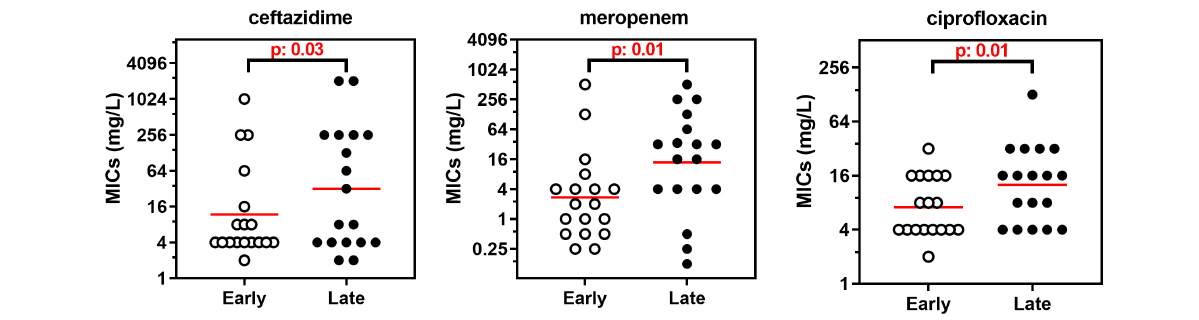
FIGURE 1 | MICs of 3 antibiotics in the 18 pairs of isolates collected successively in the same patients with an interval time ranging from 1 to 11 years. The graphs show the individual MIC for each isolate, with the geometric mean rep-resented by the red horizontal line. Only antibiotics for which a significant difference between the successive isolates (Early vs. late) was observed are illustrated (see Table 1 ). Statistical analysis: Wilcoxon matched-pairs signed-rank